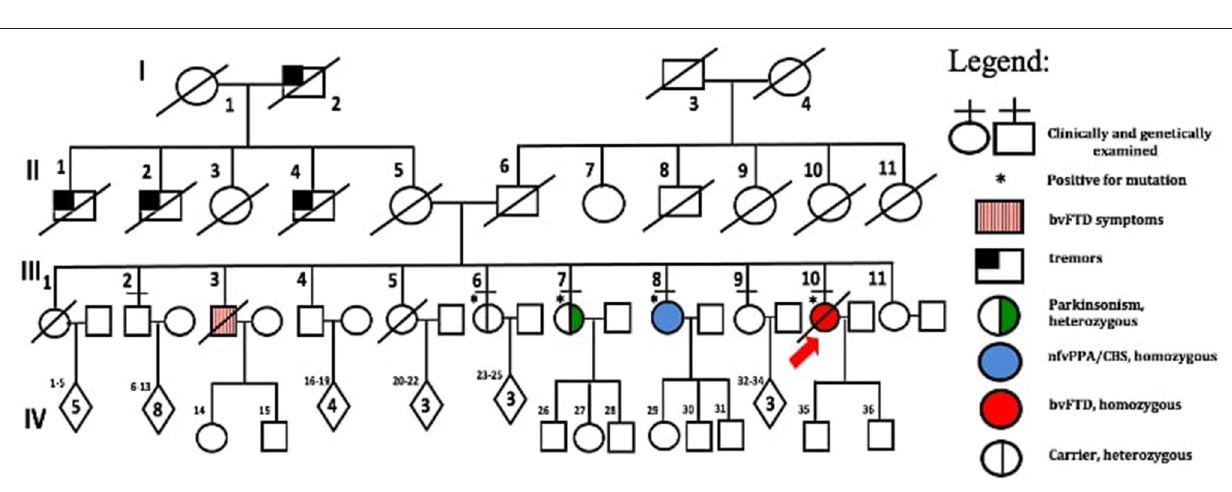
FIGURE 2 | Family pedigree with generations and subjects labeled. Standard symbols were